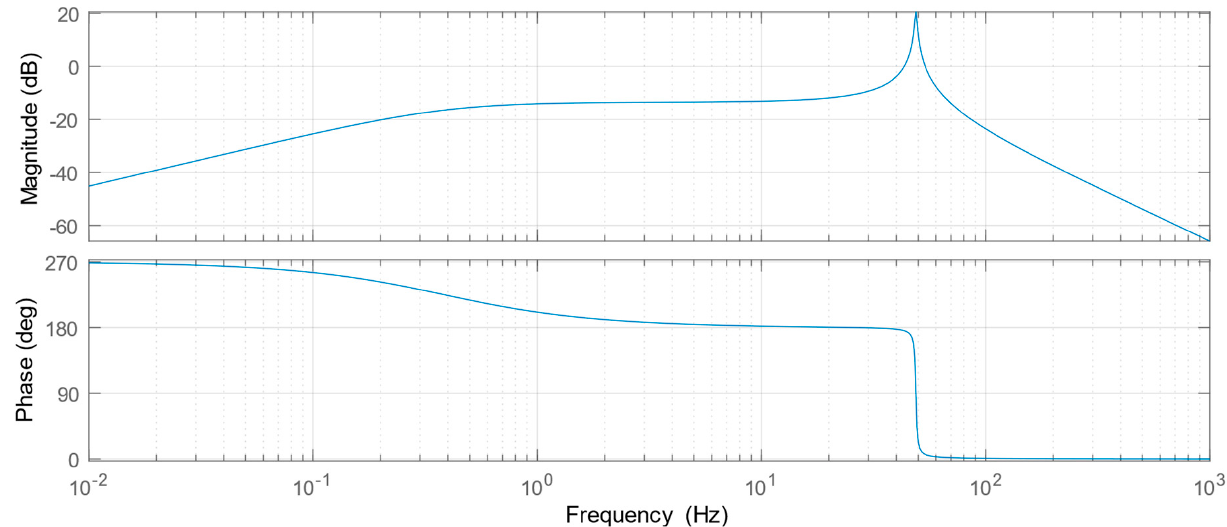
Figure 5. Bode plot of the harvester model. Peak resonance is observed at 48.8 Hz.